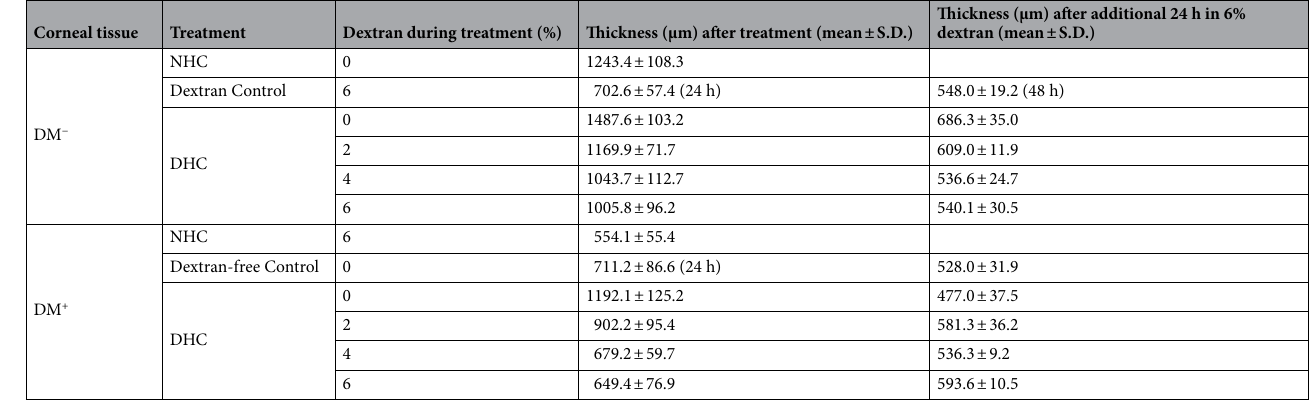
Table 1. Corneal thickness measurements by anterior segment optical coherence tomography.